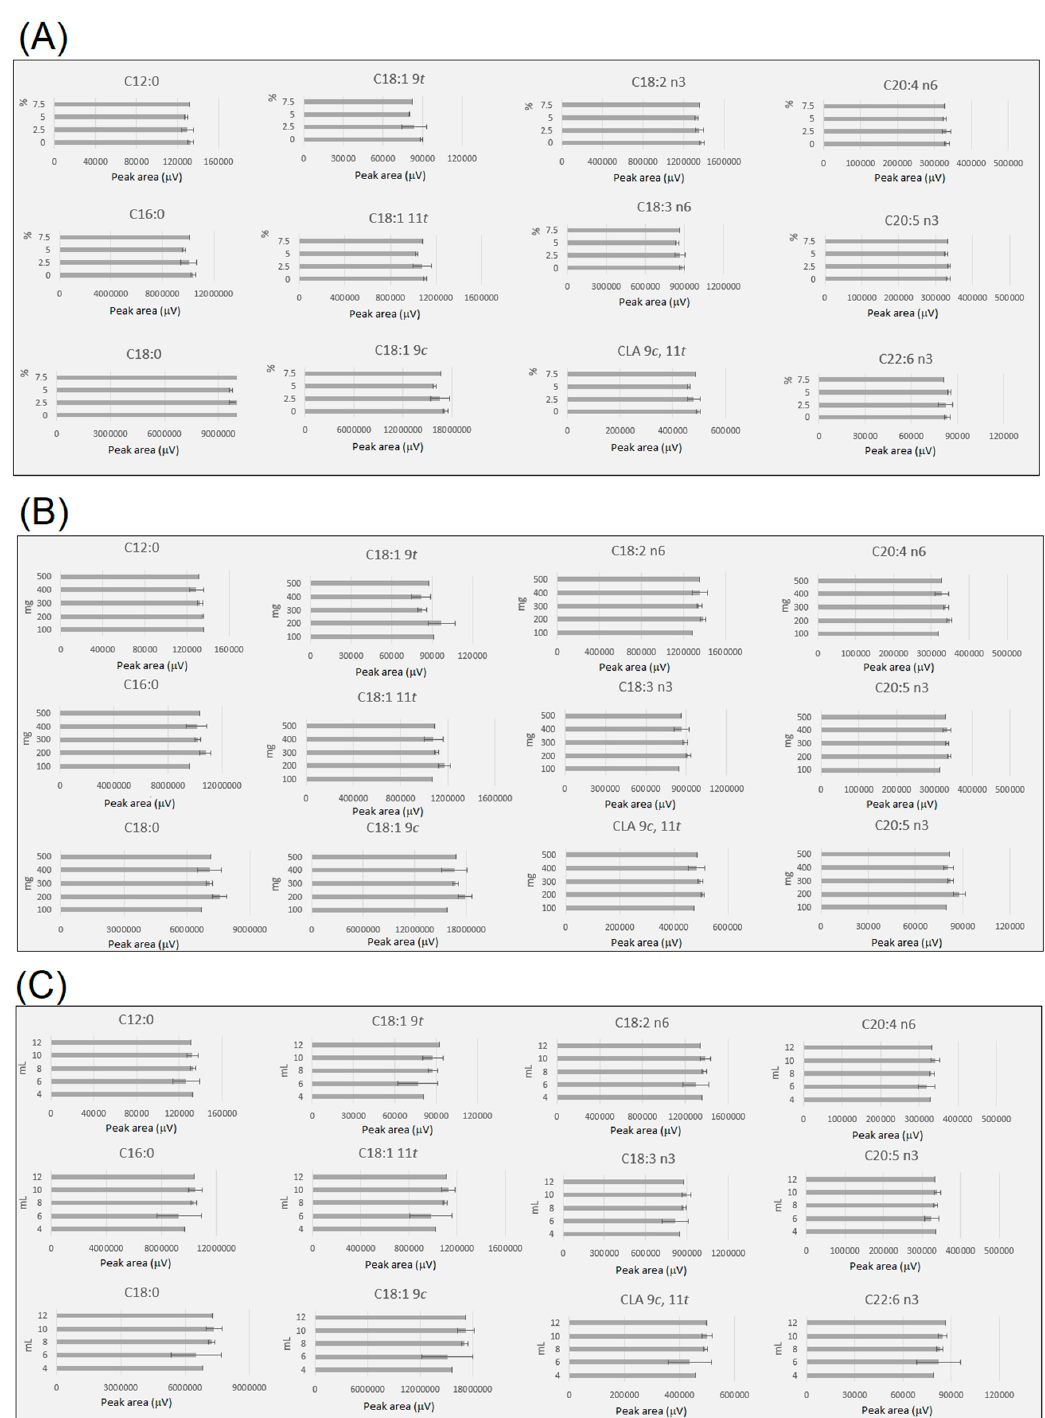
Figure 4. FAMEs yield (peak area normalised by volume of toluene and sample weight) comparison at 70 °C for 2 h under different conditions ( a )—effect of moisture content; ( b )—effect of sample weight and ( c )—effect of total solvent volume, i.e., for 6 mL equal to 3 mL of H2SO4 in methanol and 3 mL of toluene). Samples with the acid concentration range from 3 to 7 were used to obtain the mean and standard deviation under the different conditions monitored. All experiments contained at least three replicates, except for extreme conditions (i.e., a—7.5% moisture; b—100 and 500 mg and c—4 mL of total solvent. For details see Table S1.